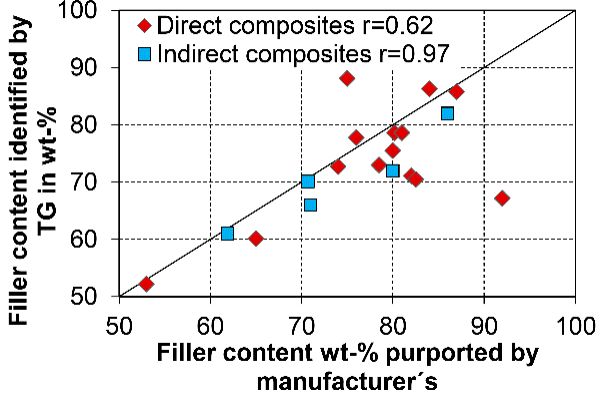
Figure 6. Filler content as identified by TG in the current study and data supplied by the manufacturers for direct (Randolph et al. 2016 [4]) and indirect RBCs (Table 3).